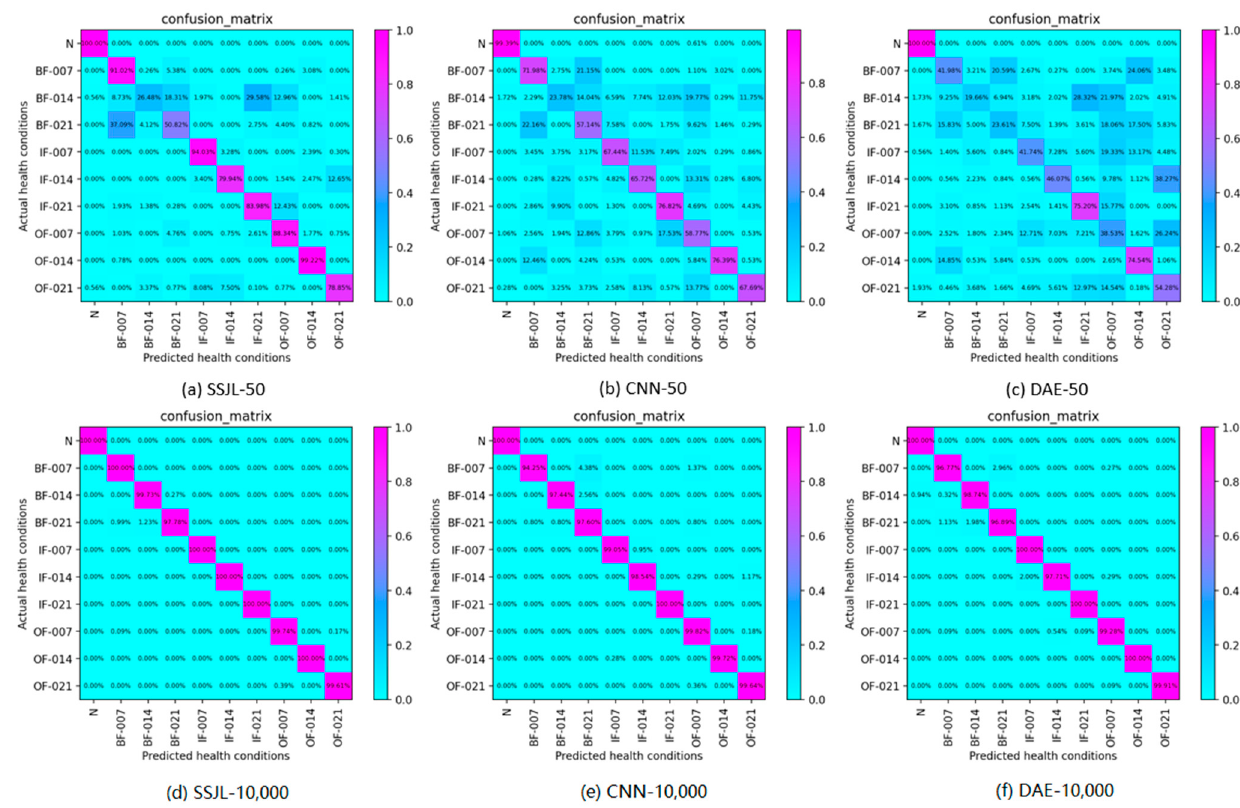
Figure 10. Confusion matrix for testing samples of the CWRU dataset: ( a ) SSJL-50, ( b ) CNN-50, ( c ) DAE-50, ( d ) SSJL-10,000, ( e ) CNN-10,000, and ( f ) DAE-10,000.